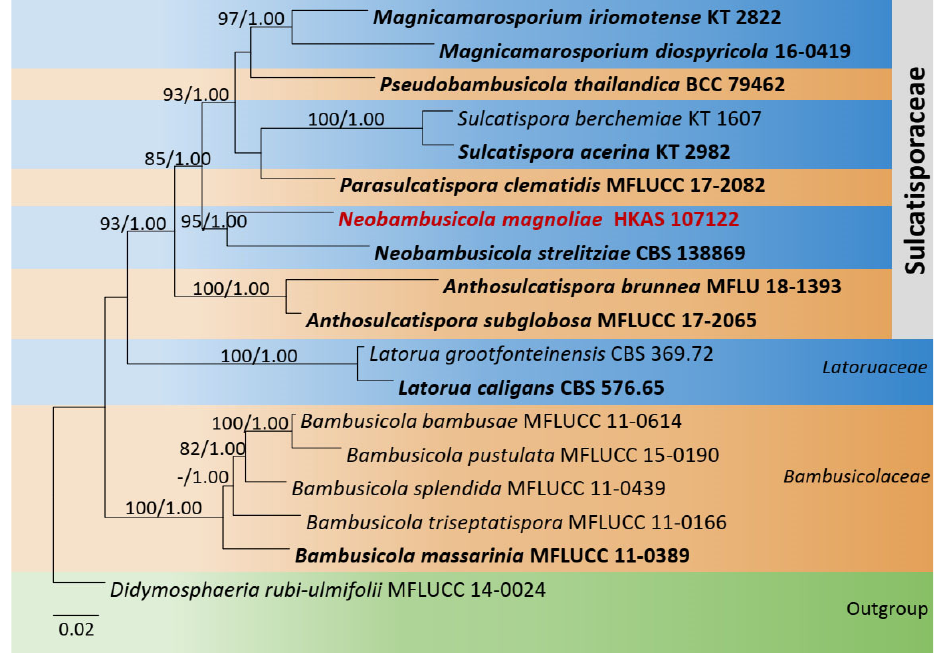
Figure 3. Phylogram generated from maximum likelihood analysis is based on combined LSU, SSU, ITS, and tef1 ‐α sequence data. Related sequences of Sulcatisporaceae were obtained from Phukhamsakda et al. [35,36]. ML bootstrap values equal to or greater than 75% and Bayesian posterior probabilities (BYPP) equal to or greater than 0.95 are indicated above the branches. The tree was rooted to Didymosphaeria rubi ‐ ulmifolii (MFLUCC 14 ‐ 0024). The newly generated sequences are indicated in red. Type and ex ‐ type strains are in bold.